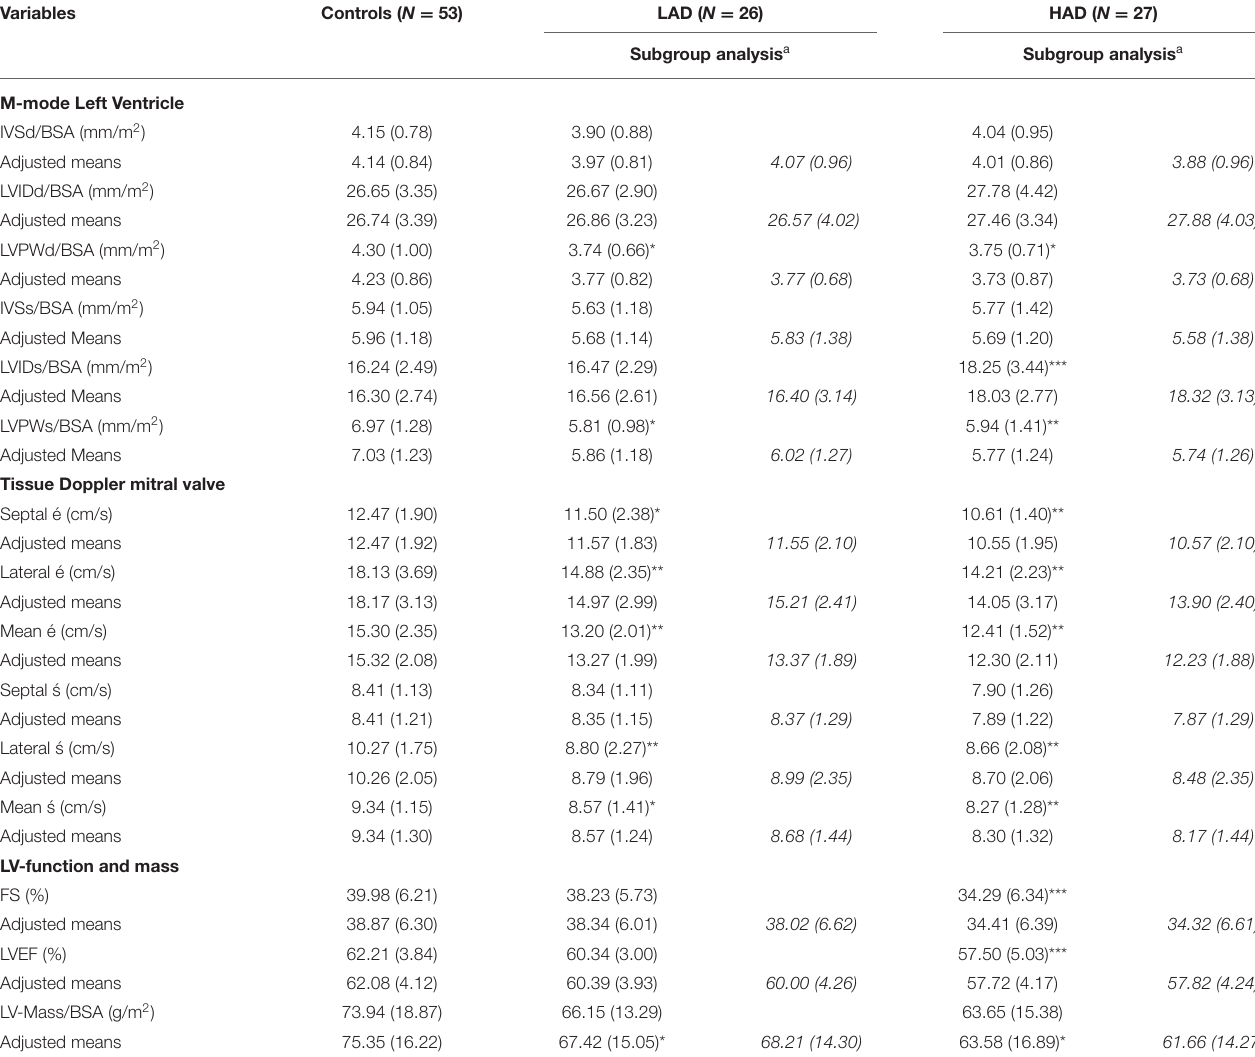
TABLE 5 | Cardiac outcomes in controls and childhood cancer survivors with low (LAD) or high (HAD) cumulative dose of anthracyclines. Variables